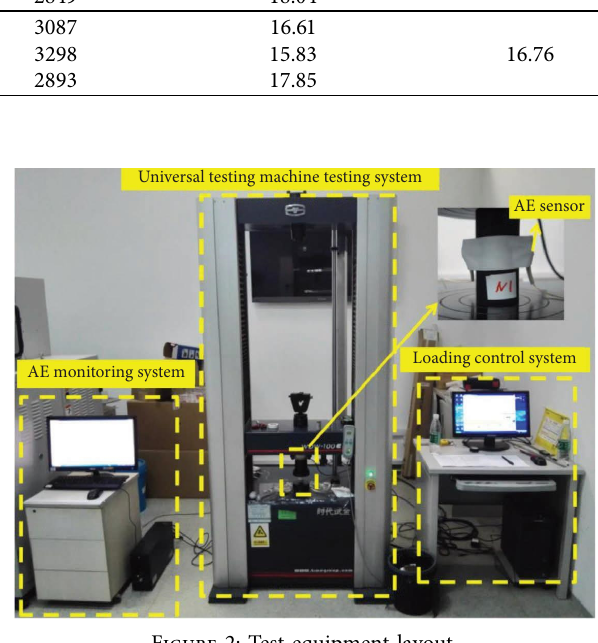
Figure 2: Test equipment layout.